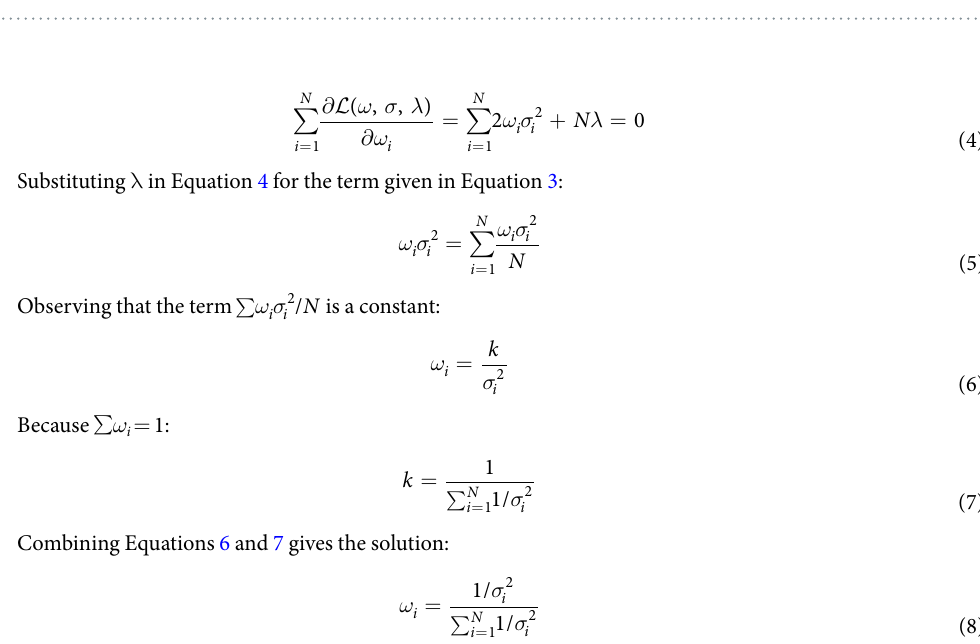
Figure 4. Axial slice at the level of the ventricles of a non-contrast CT acquired with 220 mAs exposure (left), the first time point of the 4D CT at 200 mAs, and the weighted temporal average of the 4D CT at a total exposure of 2250 mAs. All images are visualized with the same window level and width of 60 and 120